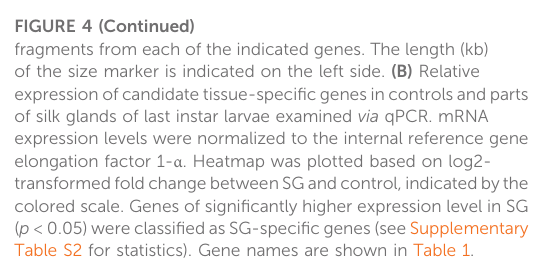
FIGURE 4 Expression of selected silk genes detected by (A) northern blottingand (B) qPCR. (A) Lanes:C – larvawithoutSG,S – larvalSG. Total RNA (5 μ g) was separated on an agarose gel, blotted to a nylon membrane and probed with [ 32 P]-labelled cDNA